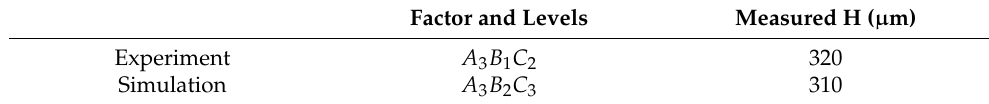
Table 10. Warpage at optimum parameters.